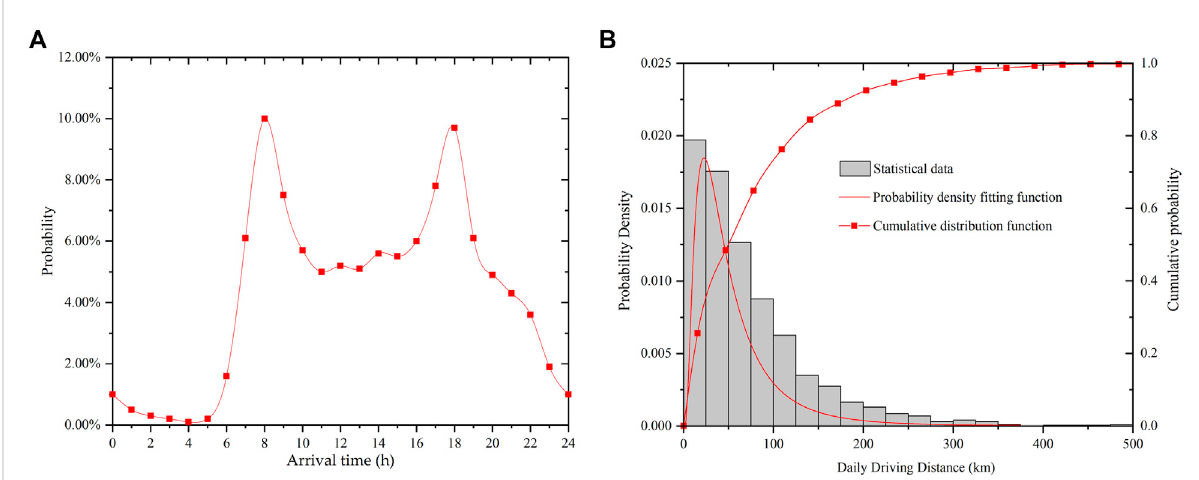
FIGURE 4 (A) TheprobabilitydensityofthedailydrivingdistanceofEVsinBeijingandthebestLog-logisticdistribution fi ttothisprobabilitydensity; (B) The probabilities for the time of initial charging during a day.